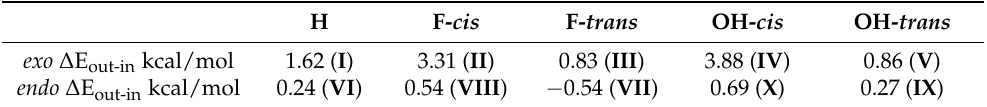
Figure 1. ORTEP presentation of structure II ( left ) and VIII ( right ) showing the intramolecular sta ‐ bilization of NH. stabilization of NH. Table 1. The difference in energy between identical molecules having NH oriented inside and outside of the molecule provided by DFT